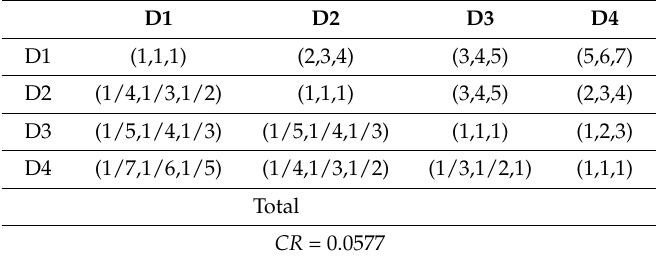
Table 9. Comparison matrix for